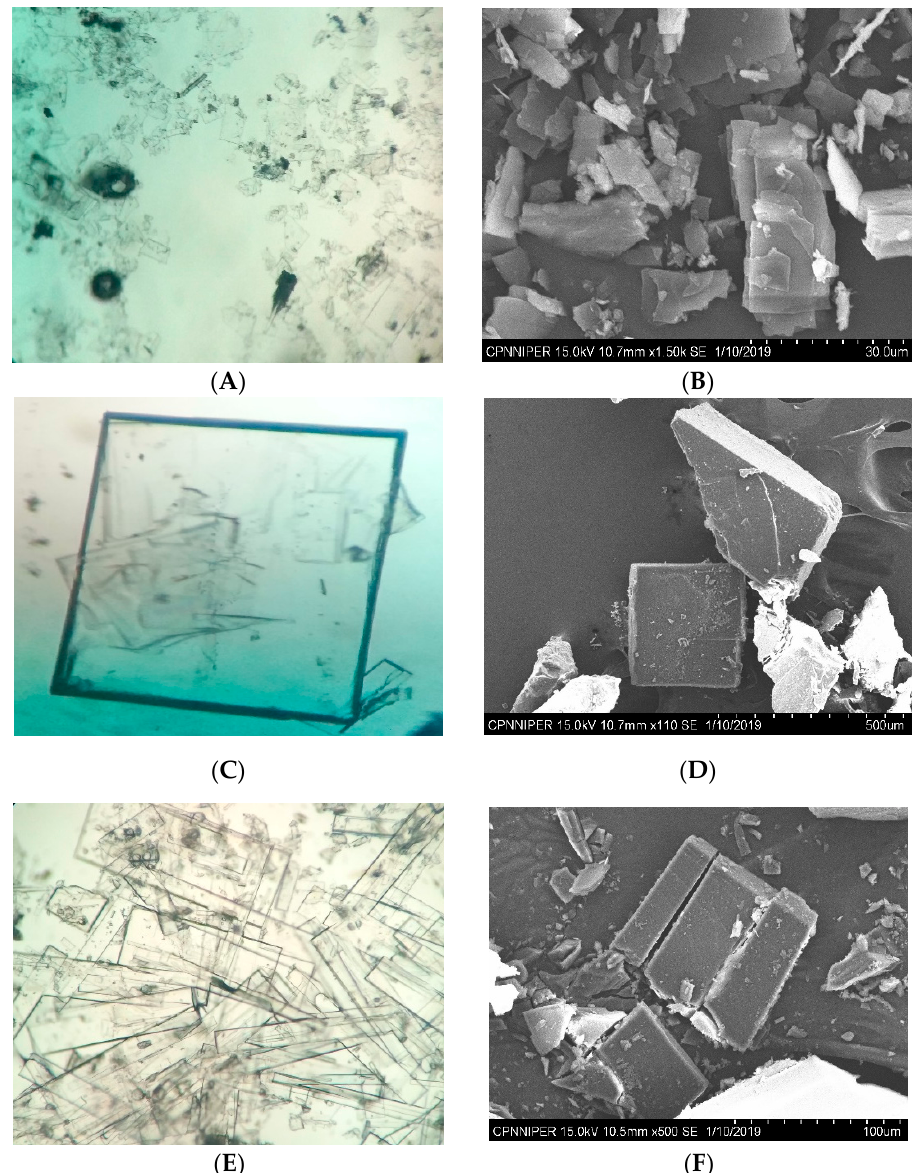
Figure 1. Compound microscope and scanning electron microscope (SEM) comparative images. ( A ) and ( B ): APT, ( C ) and ( D ): APT-AC, ( E ) and ( F ): APT-EA.